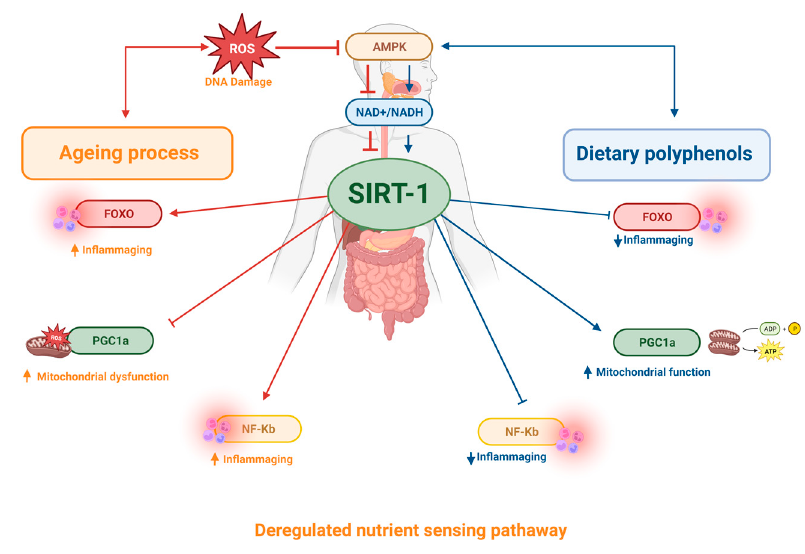
Figure 5. During ageing, in response to cellular stress, SIRT1 activity is compromised, resulting in loss of sensitivity to detect nutrients and activation of inflammation factors. Dietary polyphenol favours the activation of SIRT1, modulating senescence and cell lifespan, and therefore is associated with longevity.